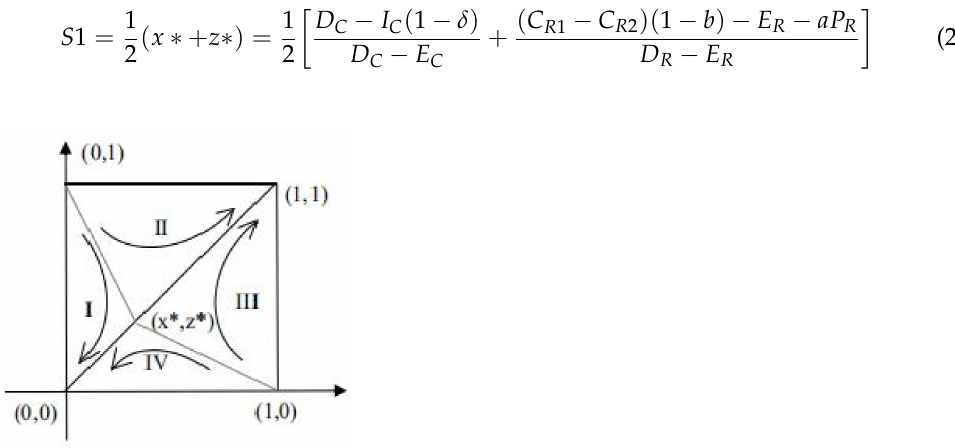
Figure 2. A phase diagram of the evolutionary game in case